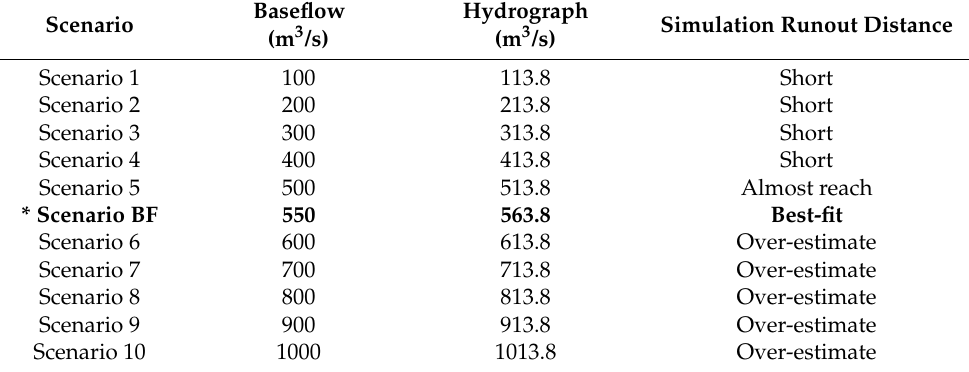
Table 4. The 11 summarized simulation scenarios by varying the baseflow and